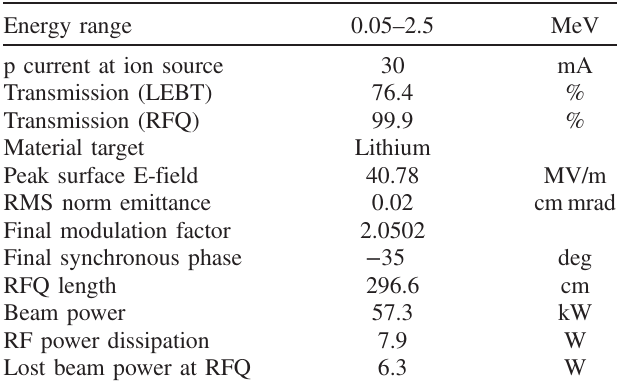
TABLE XI. Conceptional design of SC-RFQ for BNCT with a proton acceleration of 2.5